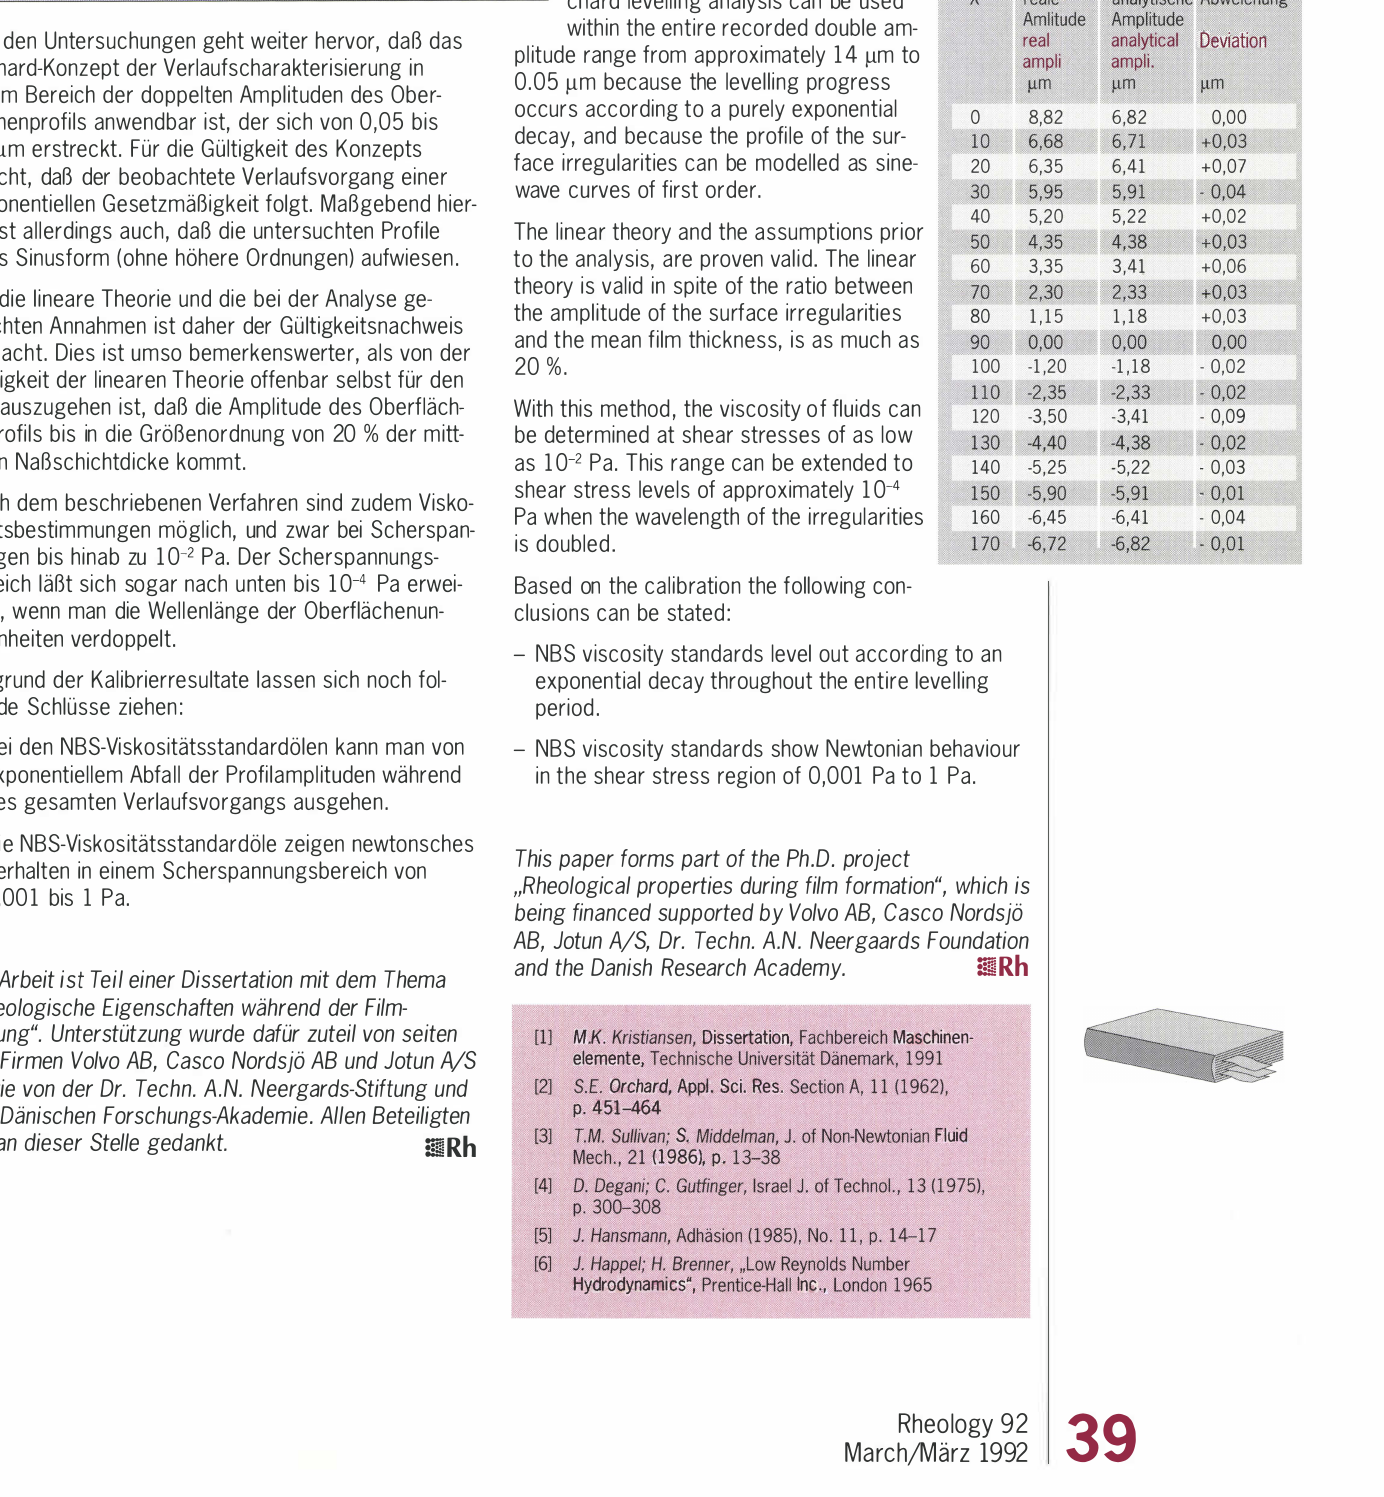
Daten des realen Oberfliichenprofils und eines rein sinusformigen Profils Comparison between the numerical data of the actual surface profile and a purely sine wave